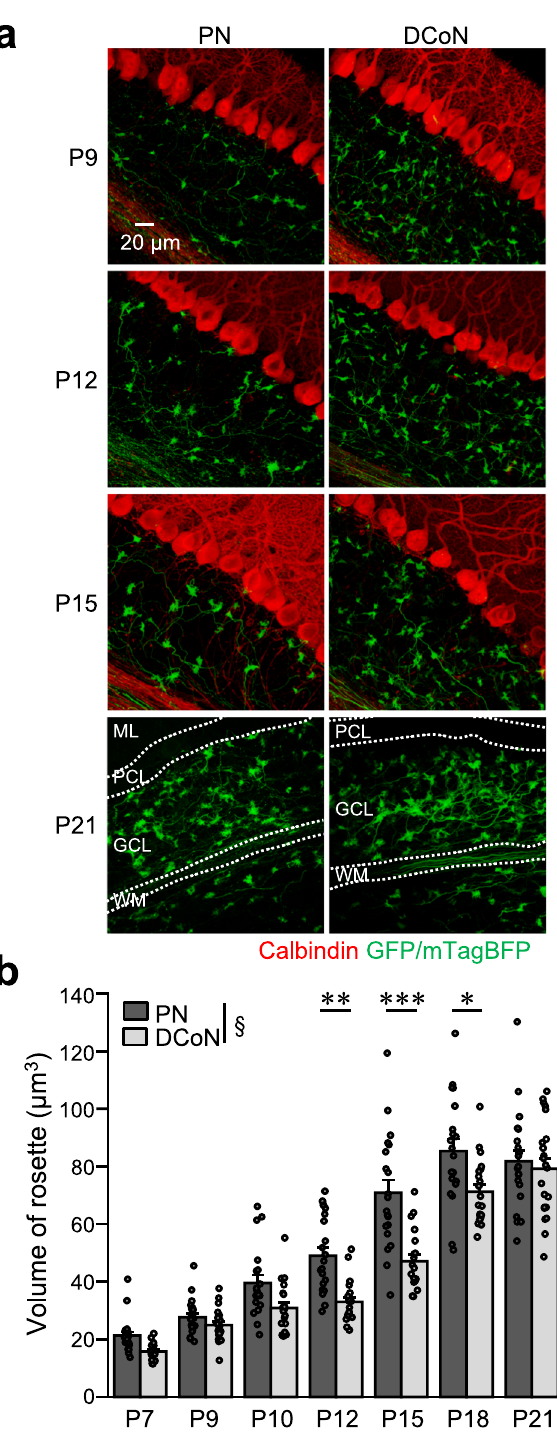
Fig. 7 Different time courses of increases in MF terminal size between PN-MFs and DCoN-MFs. a 3D projection images of sagittal cerebellar slices observed at the indicated postnatal days, in which PN-MFs or DCoN- MFs were labeled with GFP (P9, P12, and P15) or mTagBFP (P21). Slices for P9, P12, and P15 were stained (red) with a calbindin antibody. PCL, PC layer; WM, white matter. b Volume of terminals (rosette) of PN-MFs (dark gray) and DCoN-MFs (light gray). For comparison of overall time course; § p = 9.8 × 10 − 12 , two-way ANOVA, For comparison between PN and DCoN at each time; ** p = 0.0051 (P12), *** p = 3.8 × 10 − 7 (P15), * p = 0.033 (P18), two-way ANOVA followed by the Bonferroni test ( N = 4 or 7 mice, 62 mice in total, 3 – 5 images per mouse). Data are presented as mean ± s.e.m. and gray circles represent individual data